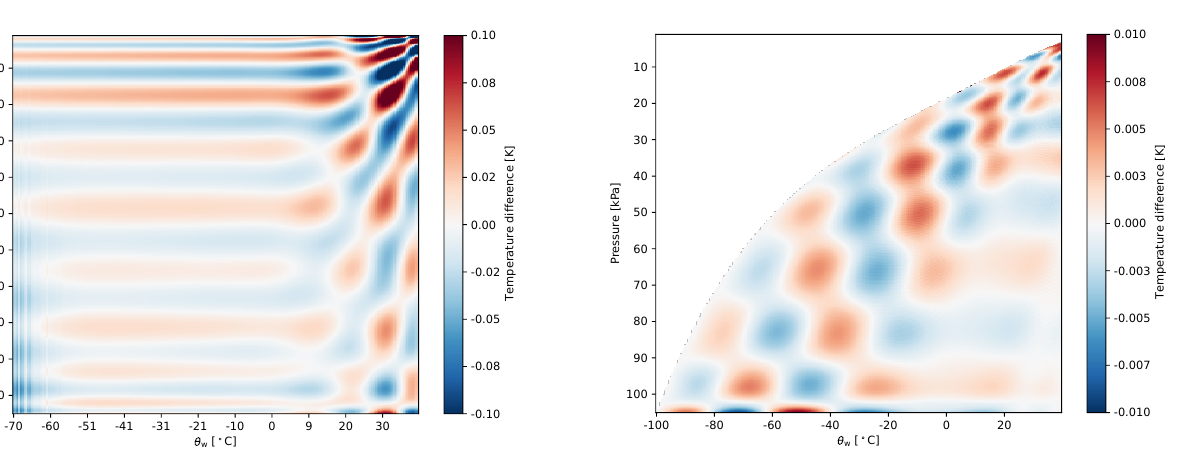
Figure 2. Approximation error between iterated (“truth”) and mod- elled T along moist adiabats θ w .